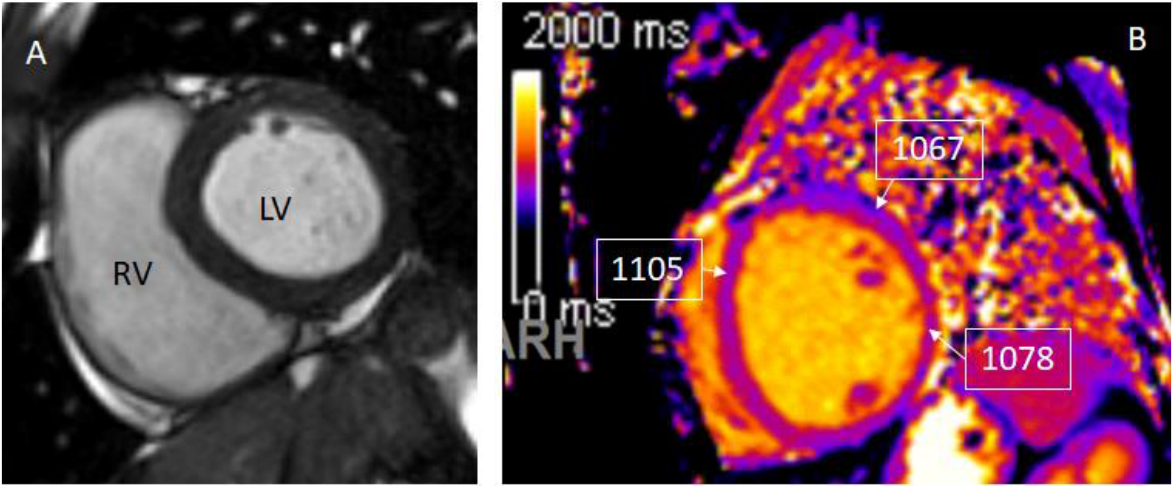
Figure 9. CMR shows no LGE (A) but diffusely elevated T1 time (B).